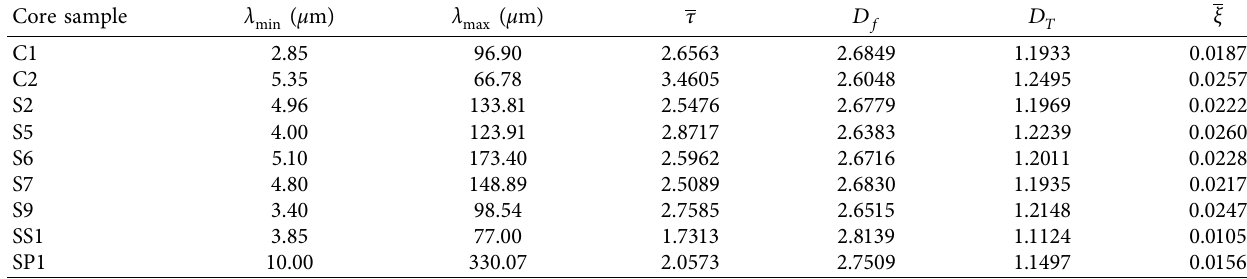
Table 2: Fractal characterization of the digital core samples listed in Table 1.